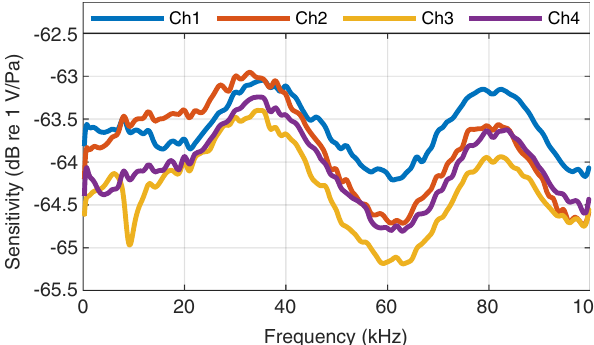
Figure 3. Free- fi eld sensitivity of the four channels of the electro-acoustic measuring chain, denoted as “ Ch1 ” (channel 1) to “ Ch4 ” (channel 4), at 0 (cid:3) incidence angle in the frequency range from 0.25 kHz to 100 kHz.